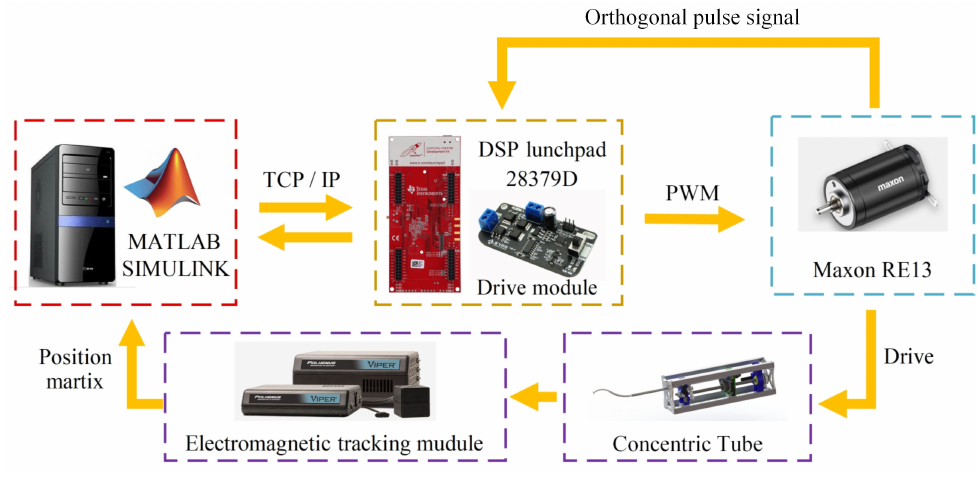
Figure 6. Control system flow.